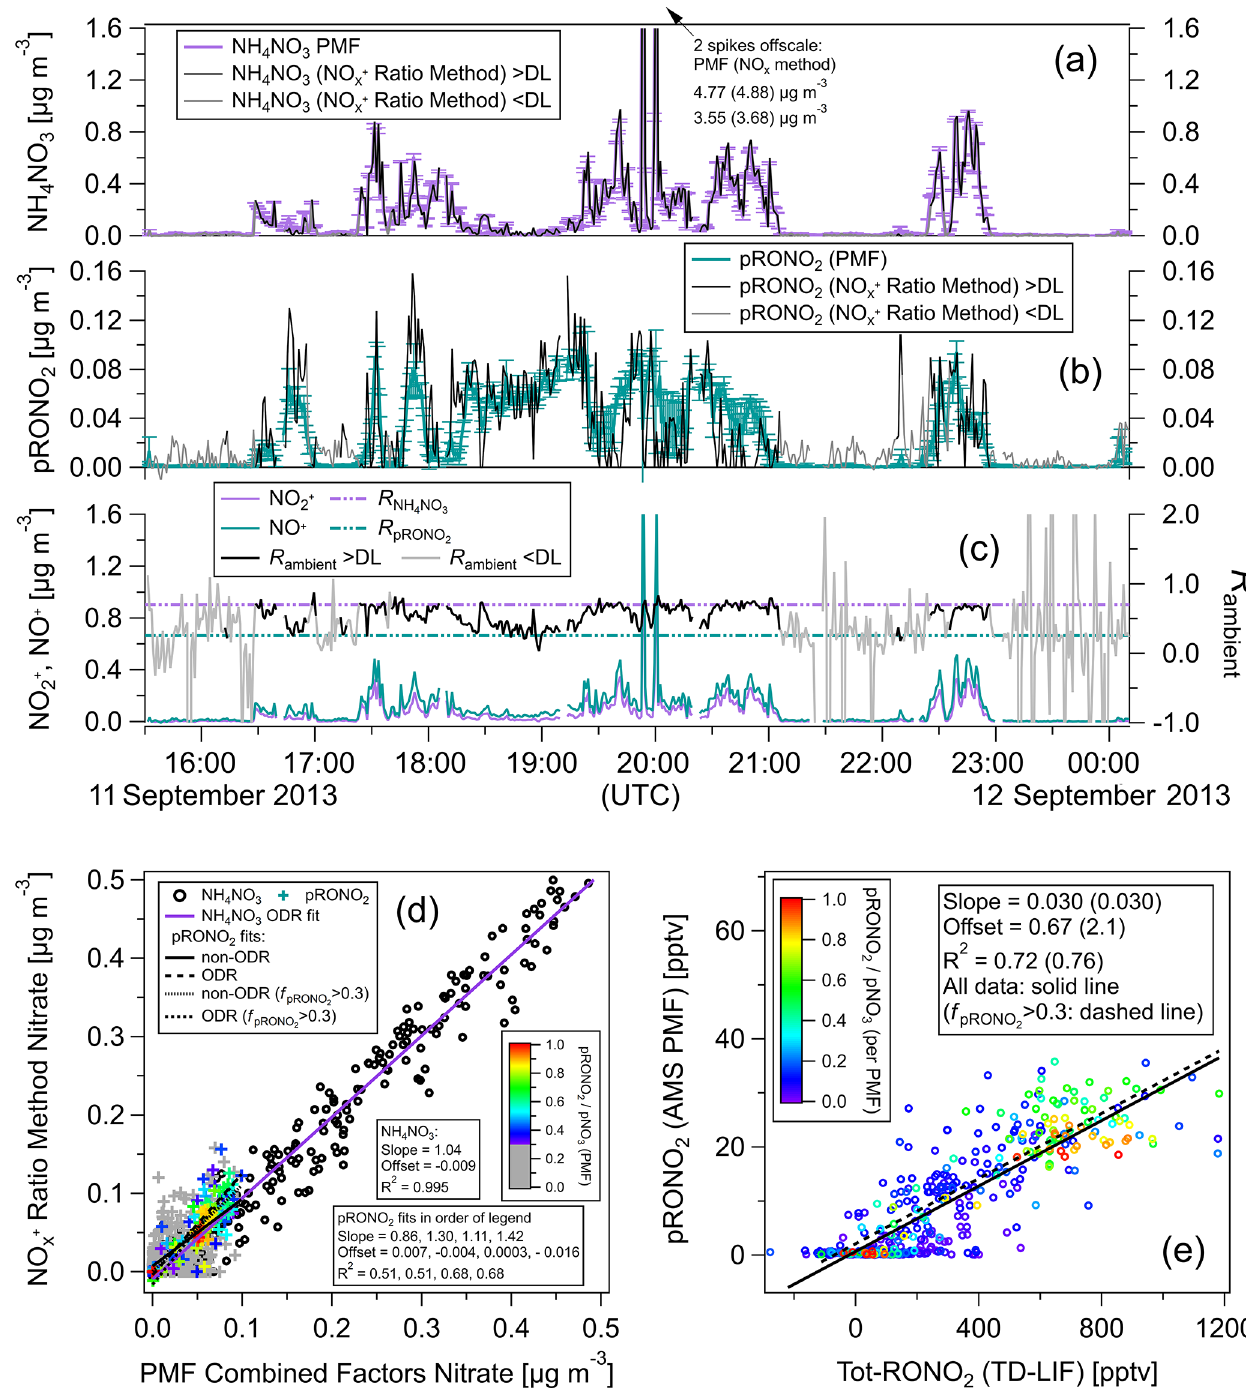
Figure 4. Comparison of NO + x ratio vs. PMF methods for calculation of NH 4 NO 3 and pRONO 2 as time series (a–c) and as scatterplots (d) for same flight shown in Fig. 3. Concentration time series calculated using the RoR method (as well as the measured NO + x signals and ratios) are shown for all data as well as only when above the R ambient detection limit (DL; approximated as when both NO + x ions are above standard AMS detection limits; Drewnick et al., 2009). (e) PMF pRONO 2 vs. TD-LIF Tot-RONO 2 (equivalent to Fig. 3b, which instead shows pRONO 2 from RoR method). pRONO 2 values in scatterplots are colored by the f pRONO (pRONO 2 / pNO 3 ) as computed using the PMF 2 method. Regression line fits, slopes, offsets, and correlation coefficients are shown using different fitting methods and criterion as indicated > 0.3). All PMF-derived concentrations are averages (and standard deviations) of in legends (including where data are limited to f pRONO 2 100 bootstrapping runs (similar results using seeding runs are shown in Fig.